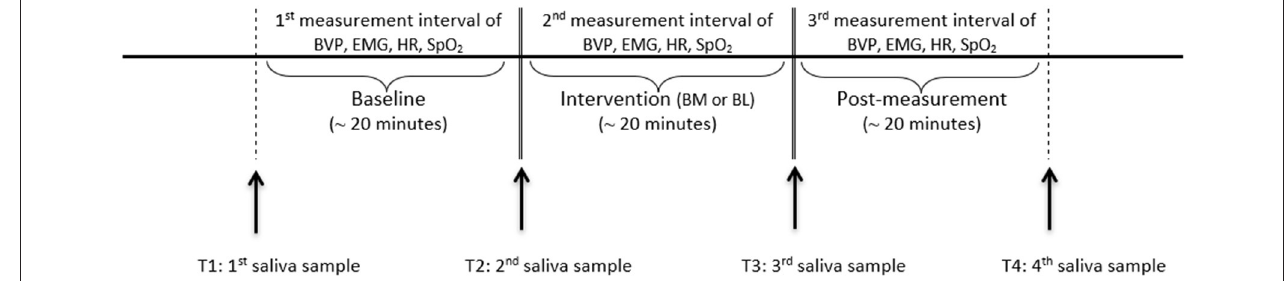
FIGURE 1 | Experimental design. BM, biographical music; BL, biographical